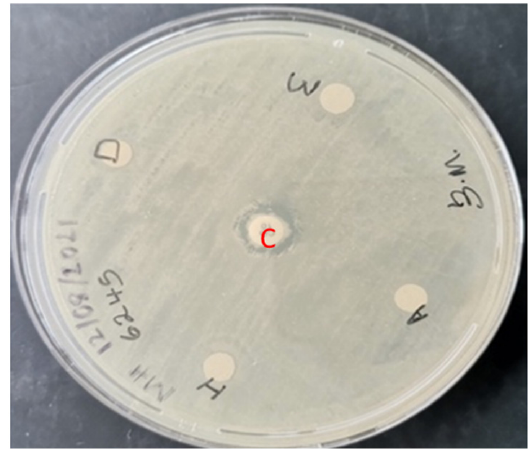
Figure 1. Screening of M. angustifolia plant extract obtained using four different solvents against A. baumannii isolate using Kirby Bauer disc diffusion. A: Acetone solvent; H: Hexane solvent; D: Dichloromethane solvent; M: Methanol solvent; C: Cefotaxim (30 µg) antibiotic used as control.